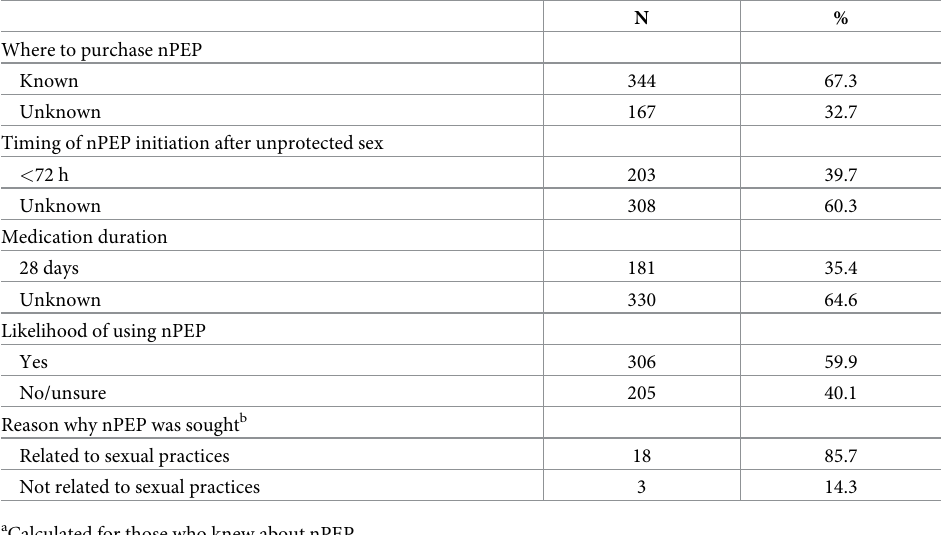
Table 3. Knowledge of nPEP among MSM recruited in 2018 and 2019 in Beijing, China (n = 511) a .